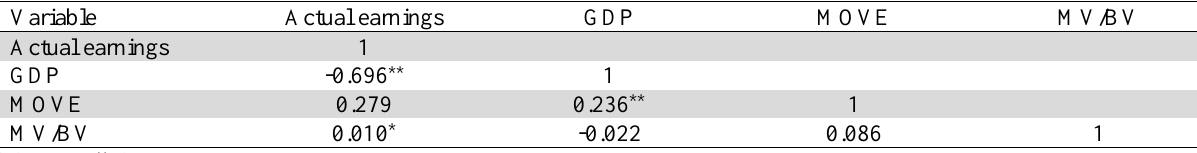
The summary of correlation test for actual earnings